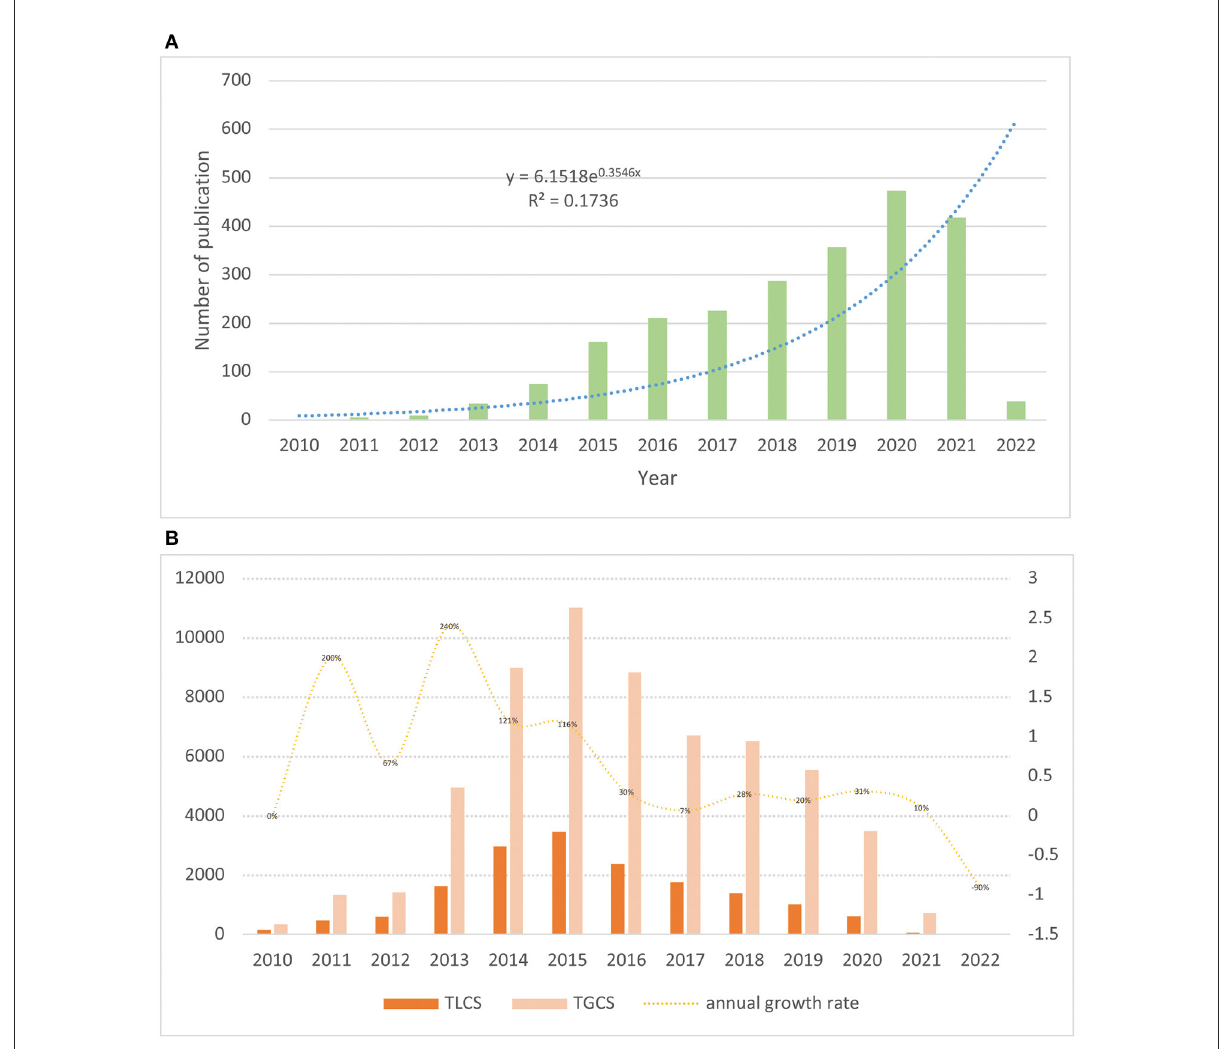
FIGURE1 (A) Global publication trend analysis of e-cigarette-related publications; (B) TGCS, TLCS, and growth rate of e-cigarette